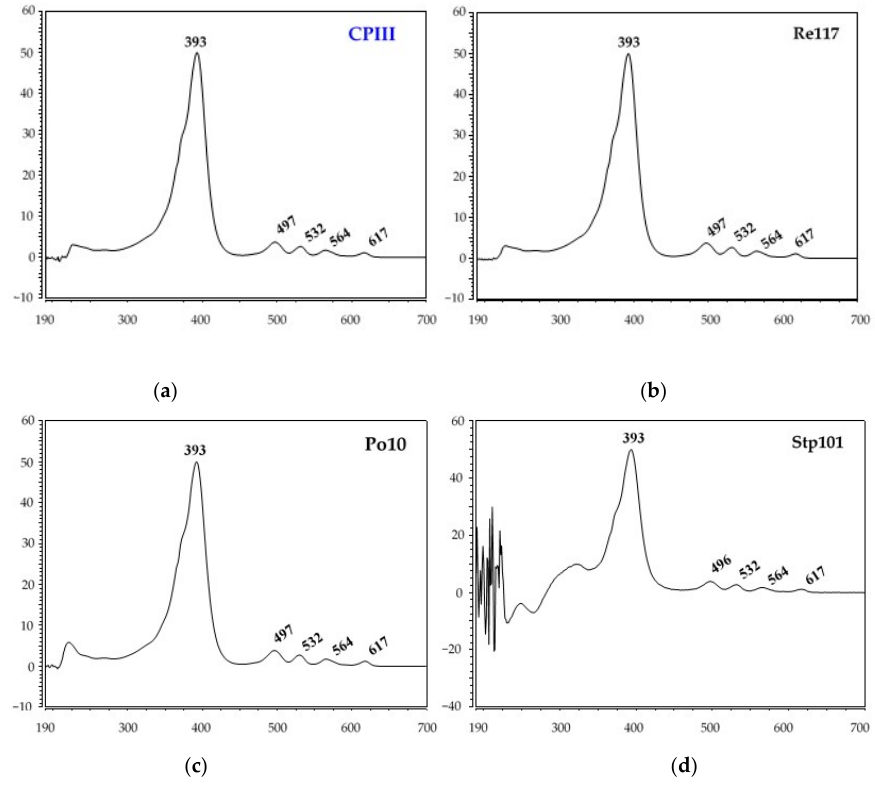
Figure 4. HPLC chromatographic profiles of red pigments extracted of G. arilaitensis strains, including ( a ) Re117, ( b ) Po102, and ( c ) Stp101.